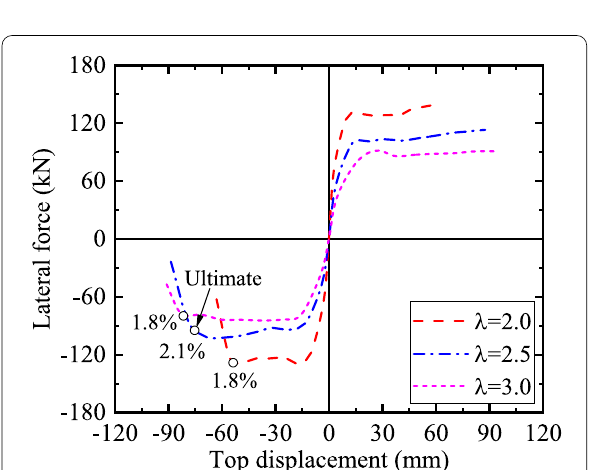
Fig. 24 Skeleton curves of specimens with different shear-to-span